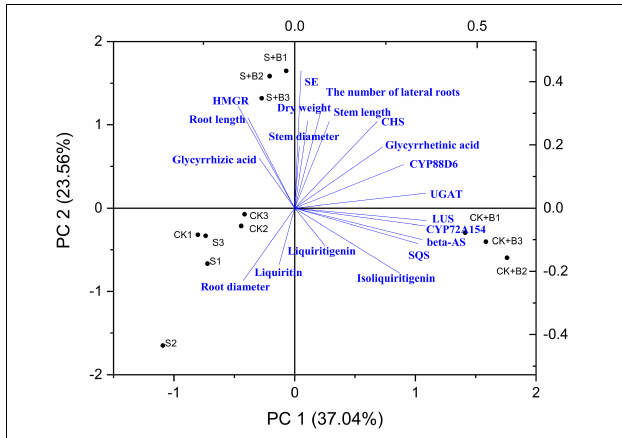
FIGURE 9 | Principal component analysis (PCA).